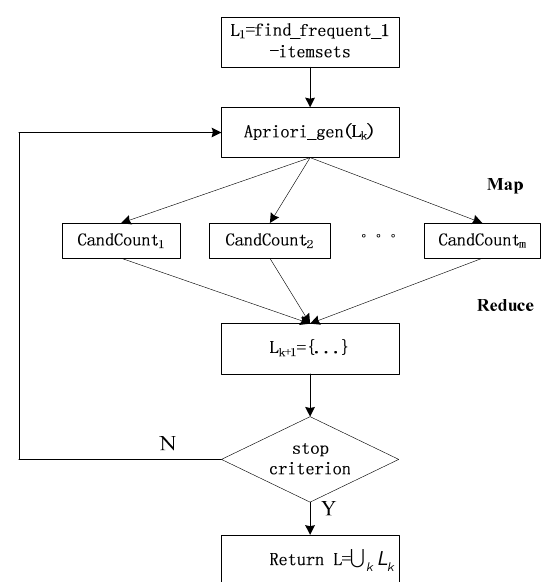
Figure 2. The flow chart of the parallel Apriori